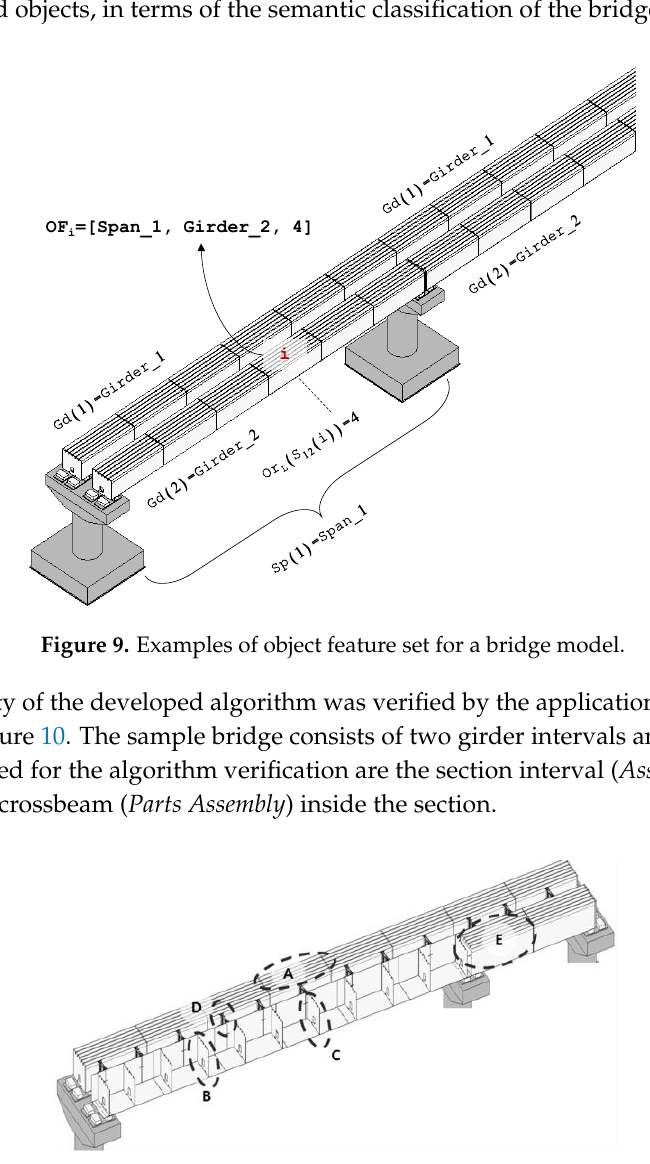
Figure 10. Sample bridge model for examining the automatic naming algorithm.